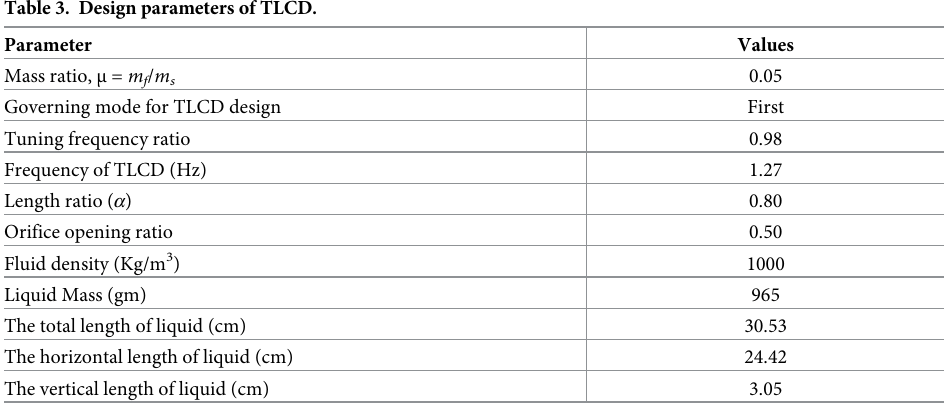
Table 3. Design parameters of TLCD.